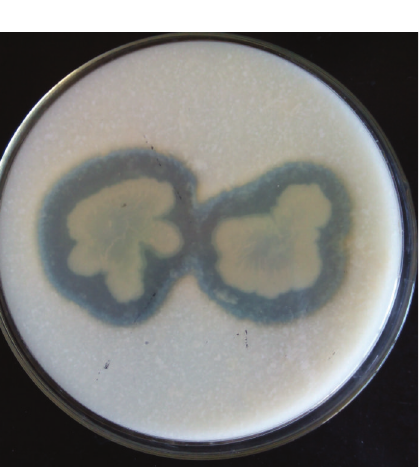
Figure 1: Screening of strain SD11 for protease activity. Isolate was streakedontheagarplatecontainingskimmedmilkpowderand10% NaCl, incubated for 24 h at 37 ∘ C. The clear hydrolysis zone indicated the hydrolysis of skimmed